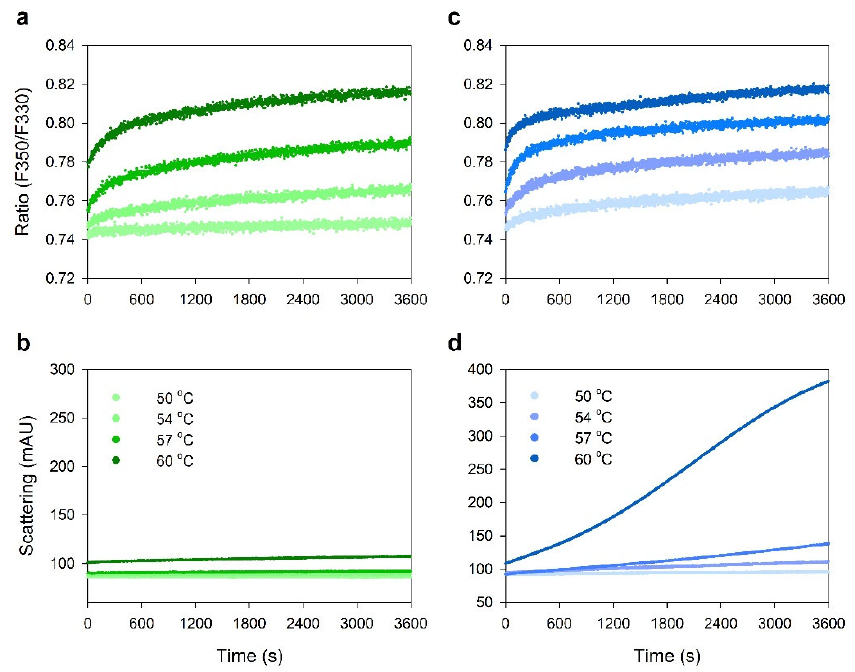
Figure 5. Isothermal stability of IgGs in acetate buffer ( a , b ) and citrate buffer ( c , d ) at the same pH of 4.6. ( a , c ) Fluorescence intensity ratio (F350 nm/F330 nm); ( b , d ) light scattering thermograms.